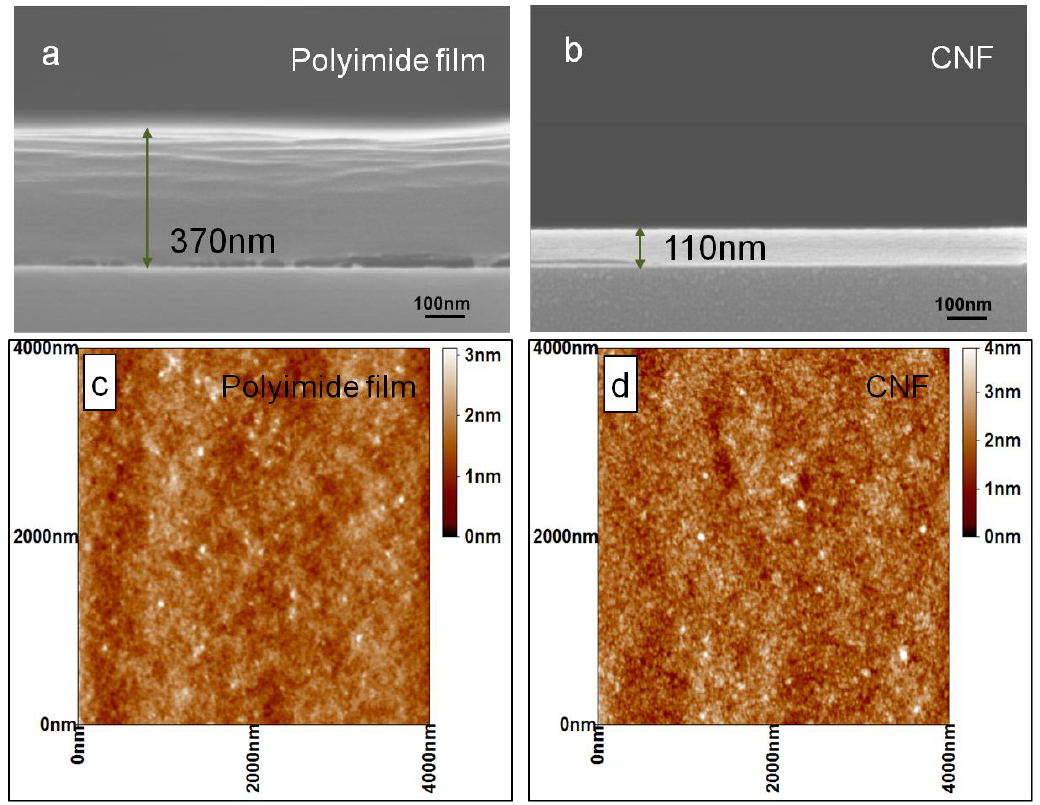
Figure 2. Cross-sectional Scanning electron microscope (SEM) images ( a , b ) and